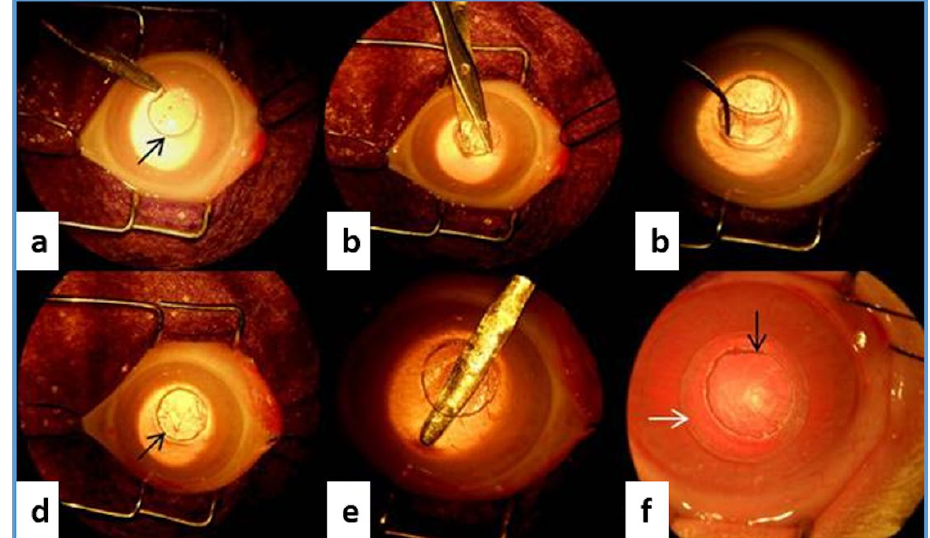
Figure 9. Implantation of BC/PCL and BC scaffolds in a rabbit’s cornea by a surgical technique (12× magnification). ( a ) Edge of the corneal trepanation (arrow). ( b , c ) Lamellar dissection. ( d ) Edge of complete superficial lamellar keratectomy (arrow). ( e ) Intrastromal insertion of spatula to produce a pocket. ( f ) Insertion of the membrane into the interlayer pocket; edge of corneal trepanation (black arrow); edge of the membrane inside the interlayer pocket (white arrow) (adapted from Sepulveda et al. [173]).